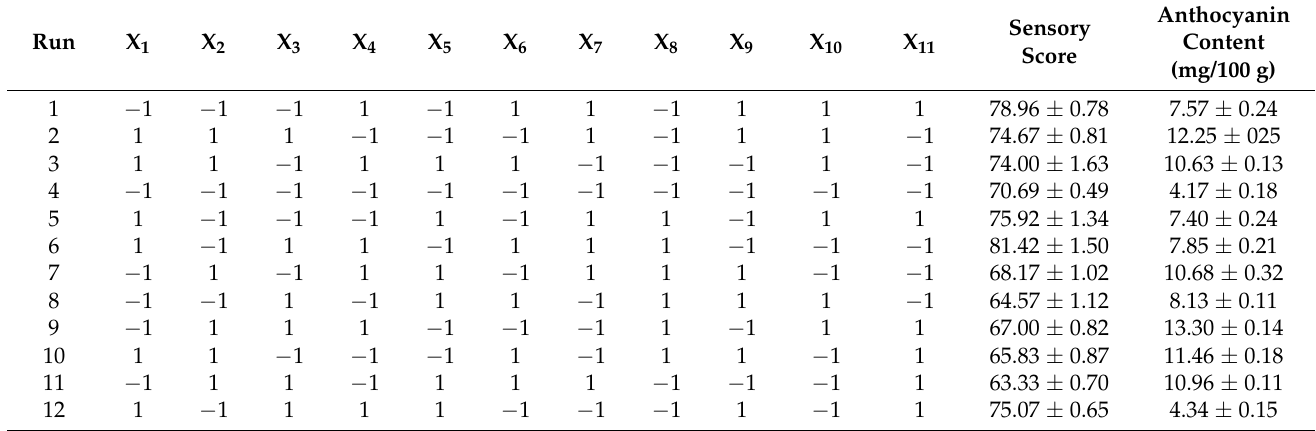
Table 3. PB test results of the sensory and anthocyanin.